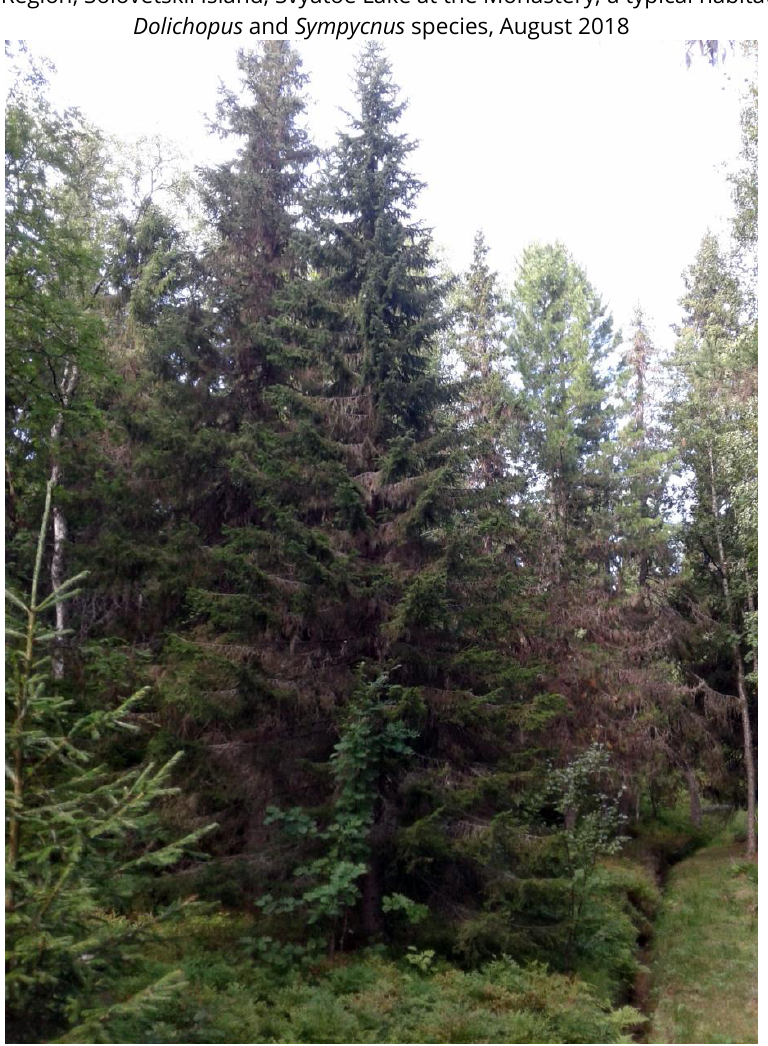
Fig. 4. Arkhangelsk Region, Solovetskii Island, a part of mixed forest with a reclamation ditch, a habitat of